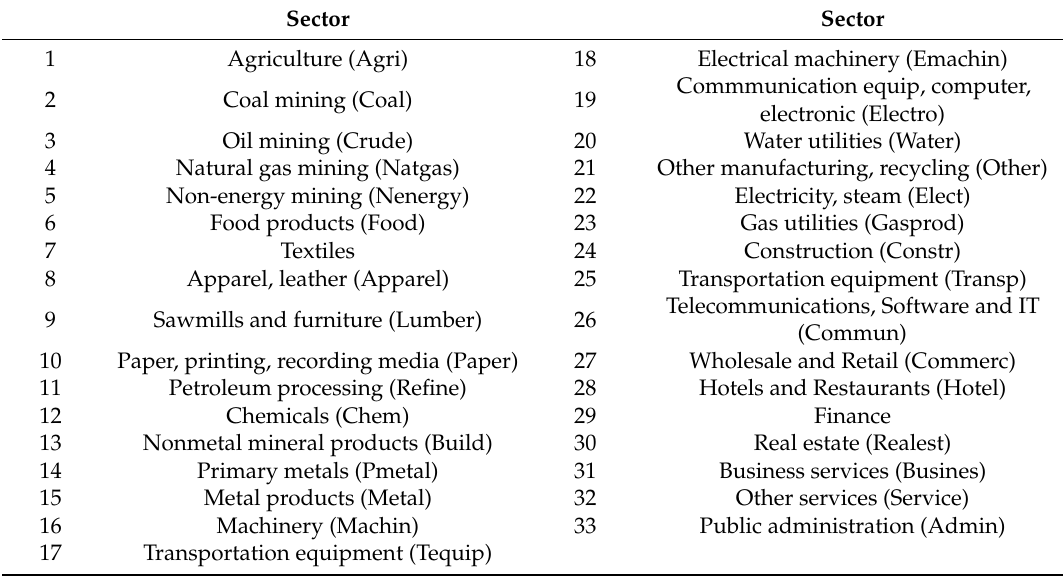
Table A1. Sectors and commodities in the dynamic CGE model of China. Sector